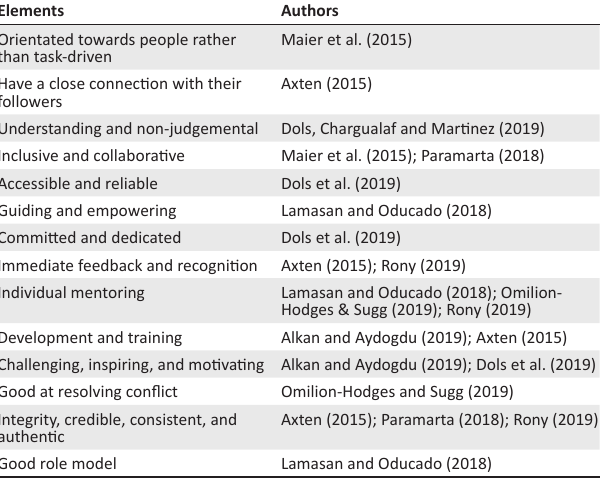
TABLE 1: Millennials’ view of elements of good